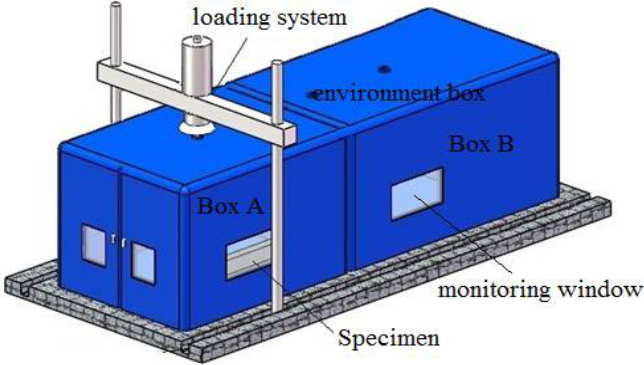
Figure 1. Design scheme of the test system with combined environment and